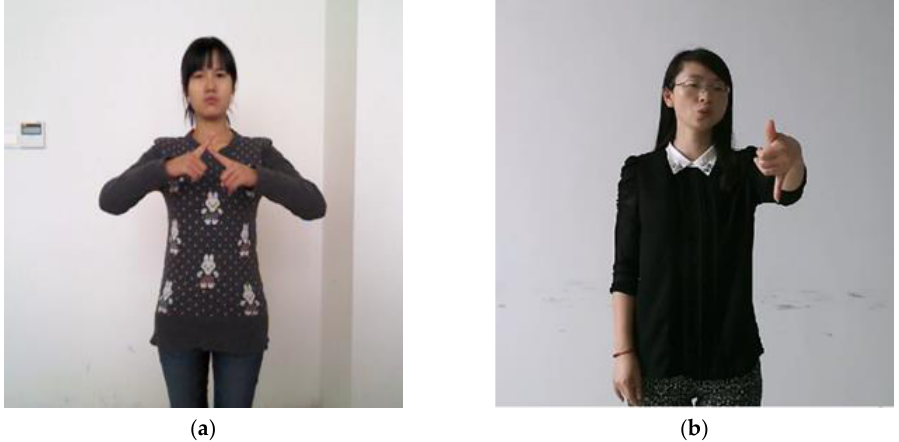
Figure 4. ( a ) Chinese sign language word “person”; ( b ) Chinese sign language word “go out”.